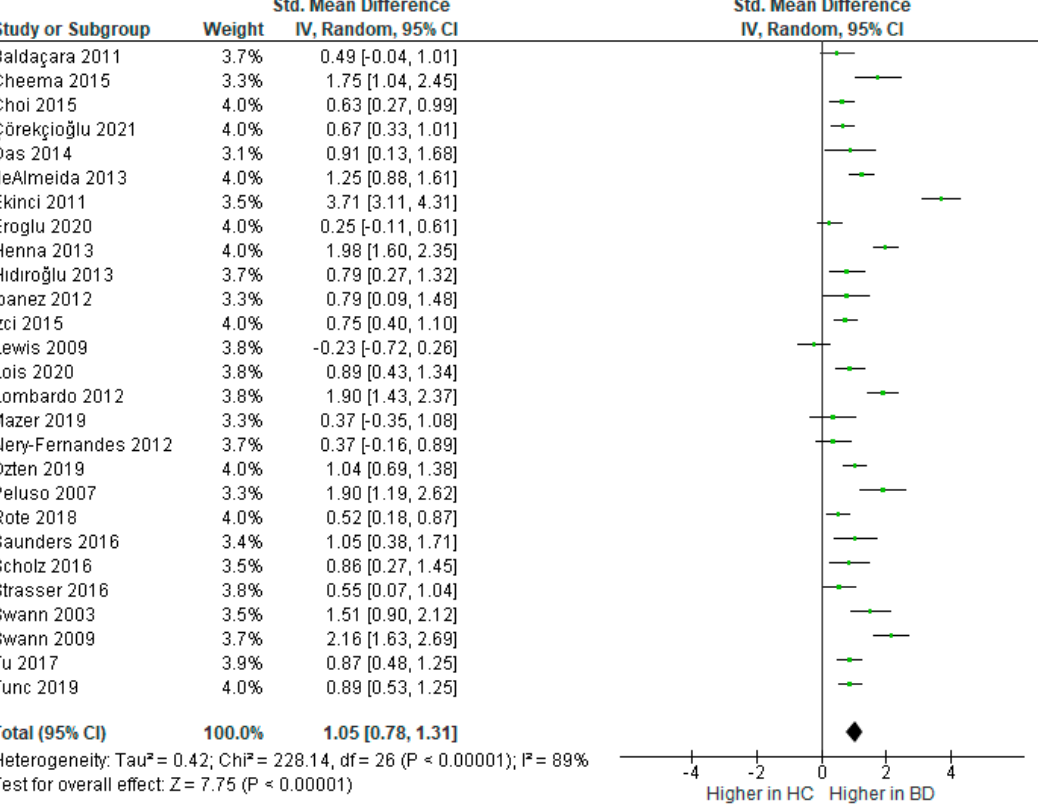
Figure 2. Forest plot of standardised mean differences (SMD) for self-reported impulsivity between bipolar disorder (BD) and healthy controls (HC).